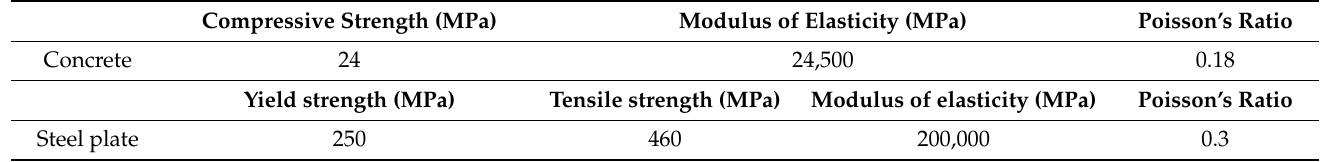
Table 1. Material properties used in the analytical